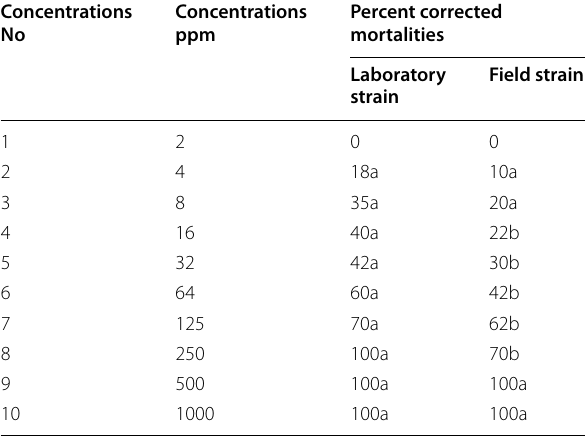
* Mortalities in the same raw followed by different letters are significantly ( P 0.05) different from each other according to Tukey’s test ≤